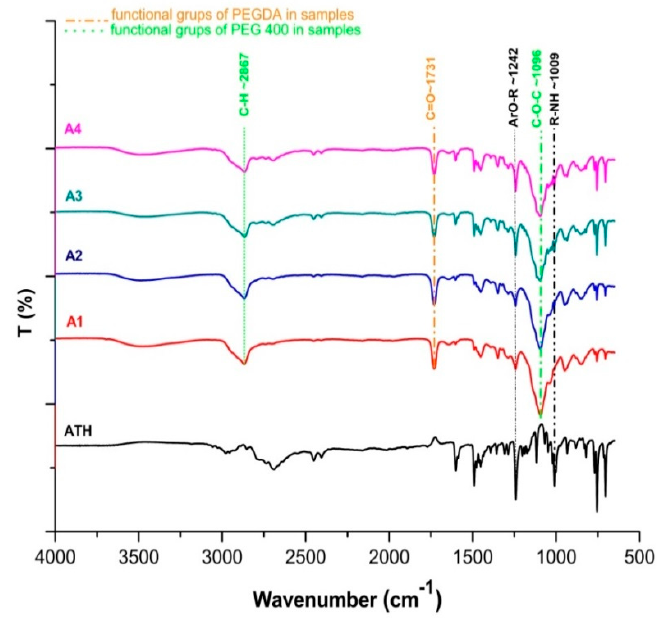
Figure 8. FT-IR spectra of pure ATH and A1-A4 formulations.